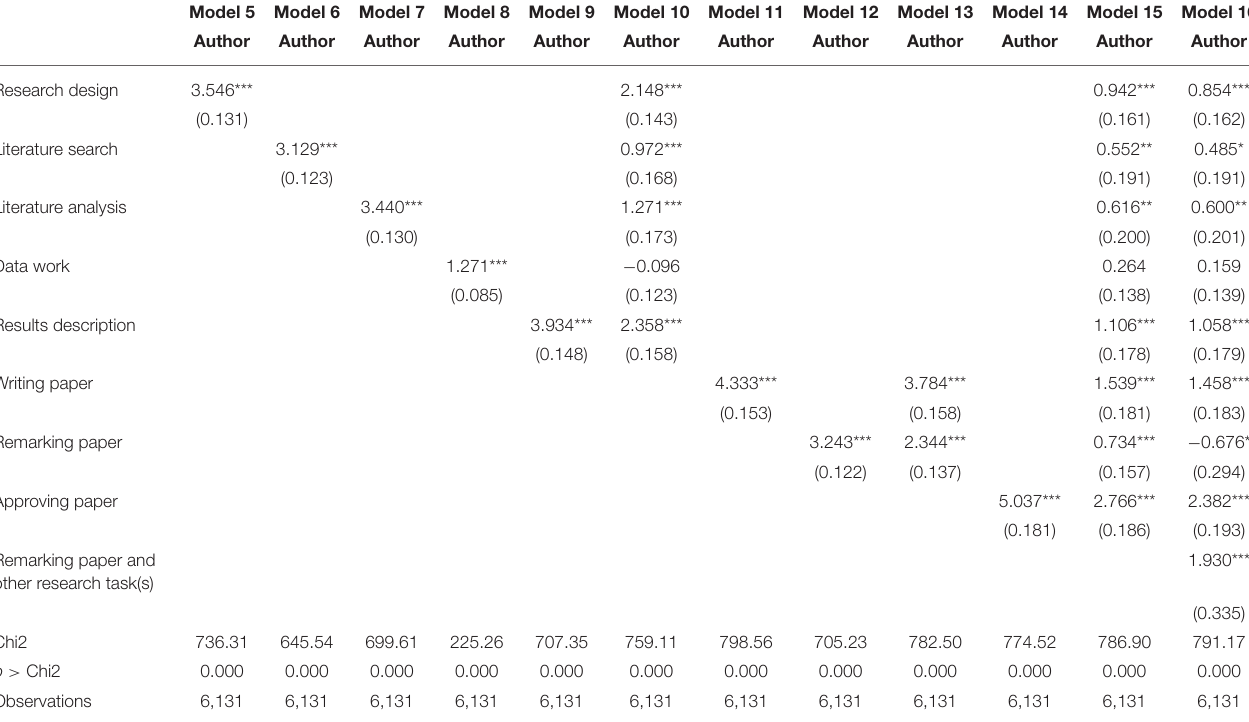
TABLE 6 | Effects of research tasks on